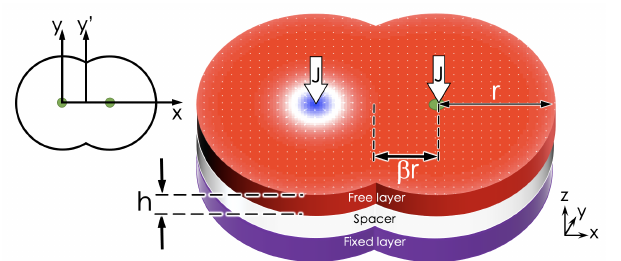
Figure 1. Schematic representation of an STNO system with a double disk geometry. A spin-polarized current is injected through each dot